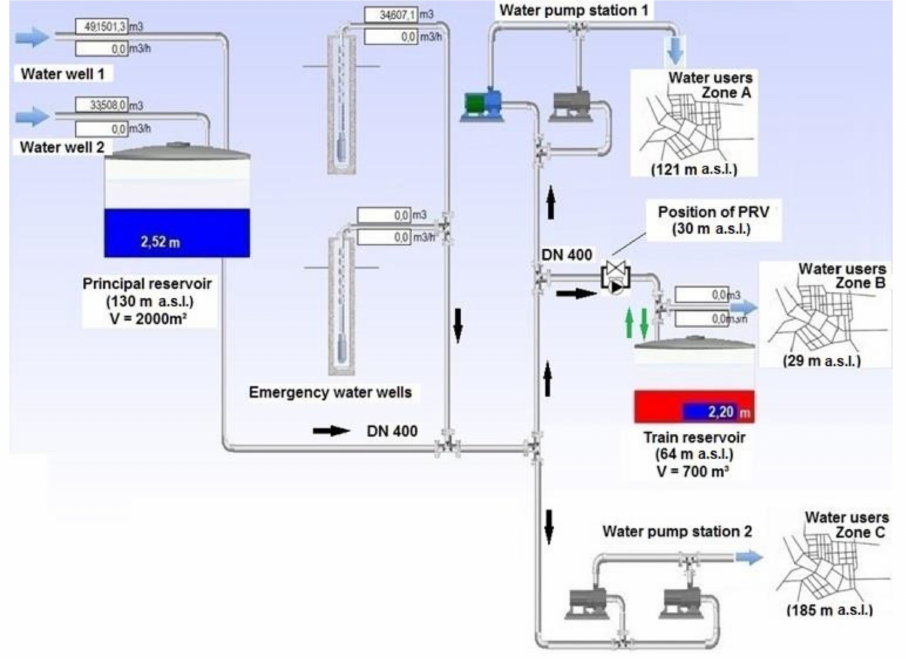
Figure 2. Synoptic diagram of the drinking water distribution network in C á rtama